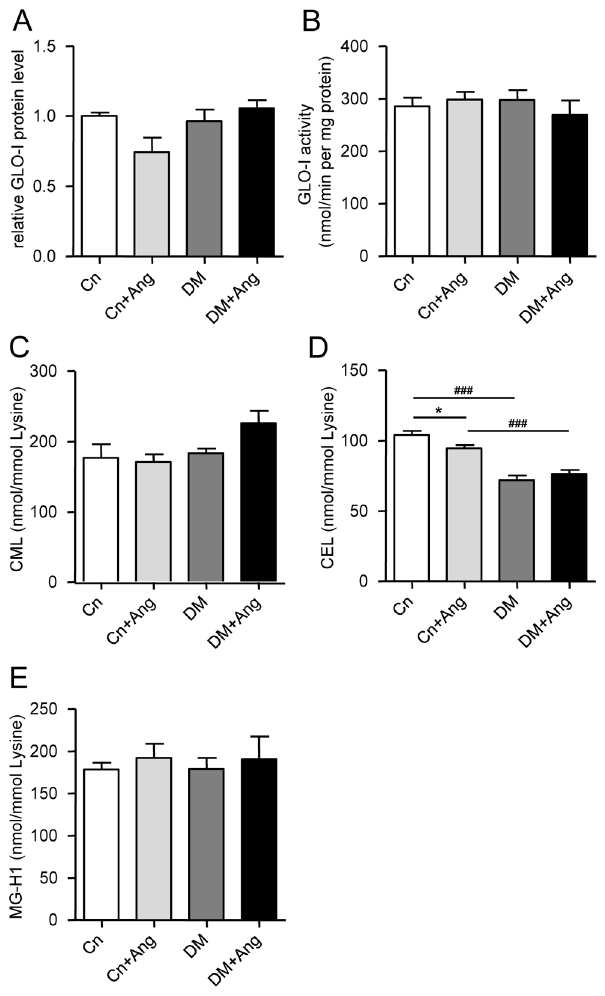
Figure 5. Effect of hypertension on cardiac AGE metabolism in non-diabetic and diabetic mice. Cardiac levels of GLO-1 protein (A), GLO-1 activity (B), CML (C), CEL (D), and MG-H1 (E) in non-diabetic (Cn) and diabetic (DM) mice treated with vehicle or AngII (Ang) for 4 weeks (age 18 weeks). Data are analyzed by one-way ANOVA with Bonferroni post-hoc testing and expressed as mean 6 SEM (n = 4–6 per group) * refers to effect of AngII in non-diabetic and diabetic mice (* P , 0.05, ** P , 0.01, *** P , 0.001) and # refers to effect of diabetes in vehicle- treated and AngII-treated mice ( # P , 0.05, ## P , 0.01, ### P , 0.001).